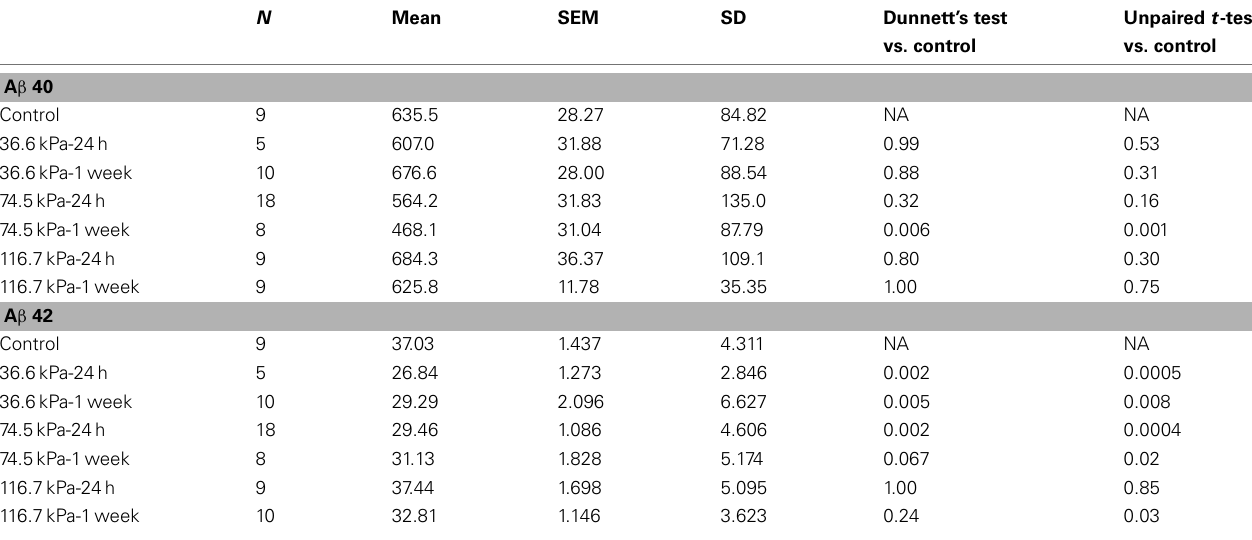
Table 1 | Levels of abeta 40 and 42 in blast exposed rats.